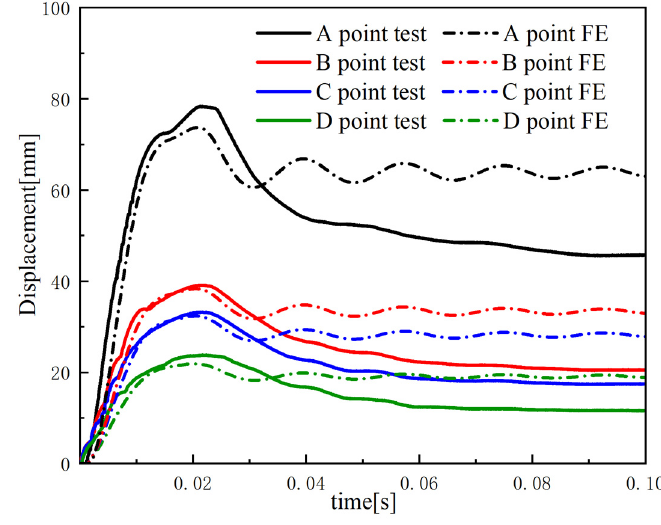
Figure 13. Displacement time-history curves from experiment and finite element simulation.